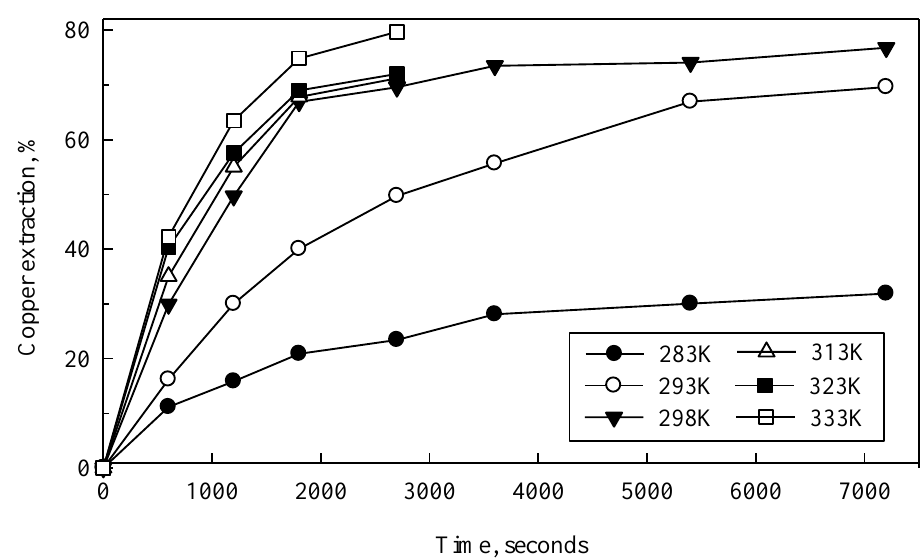
Figure 6. Results of copper extraction as a function of time for different temperatures. Working conditions: pH = 10.5, [NH 4 OH] = 0.7 mol/dm 3 , PS = 64 m, Agitation = 500 rpm, ratio = 1000/1.